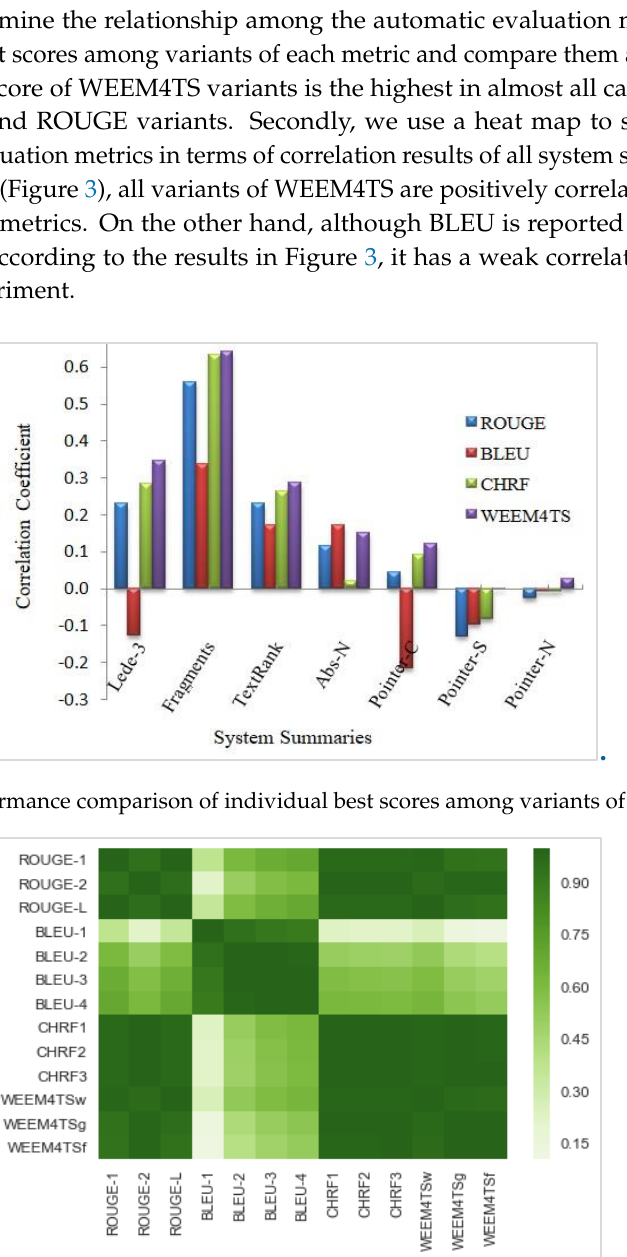
Figure 3. Pearson’s correlation heat map of automatic evaluation metrics. Deep green indicates strong positive correlation, light green is a medium whereas white is a weak correlation.